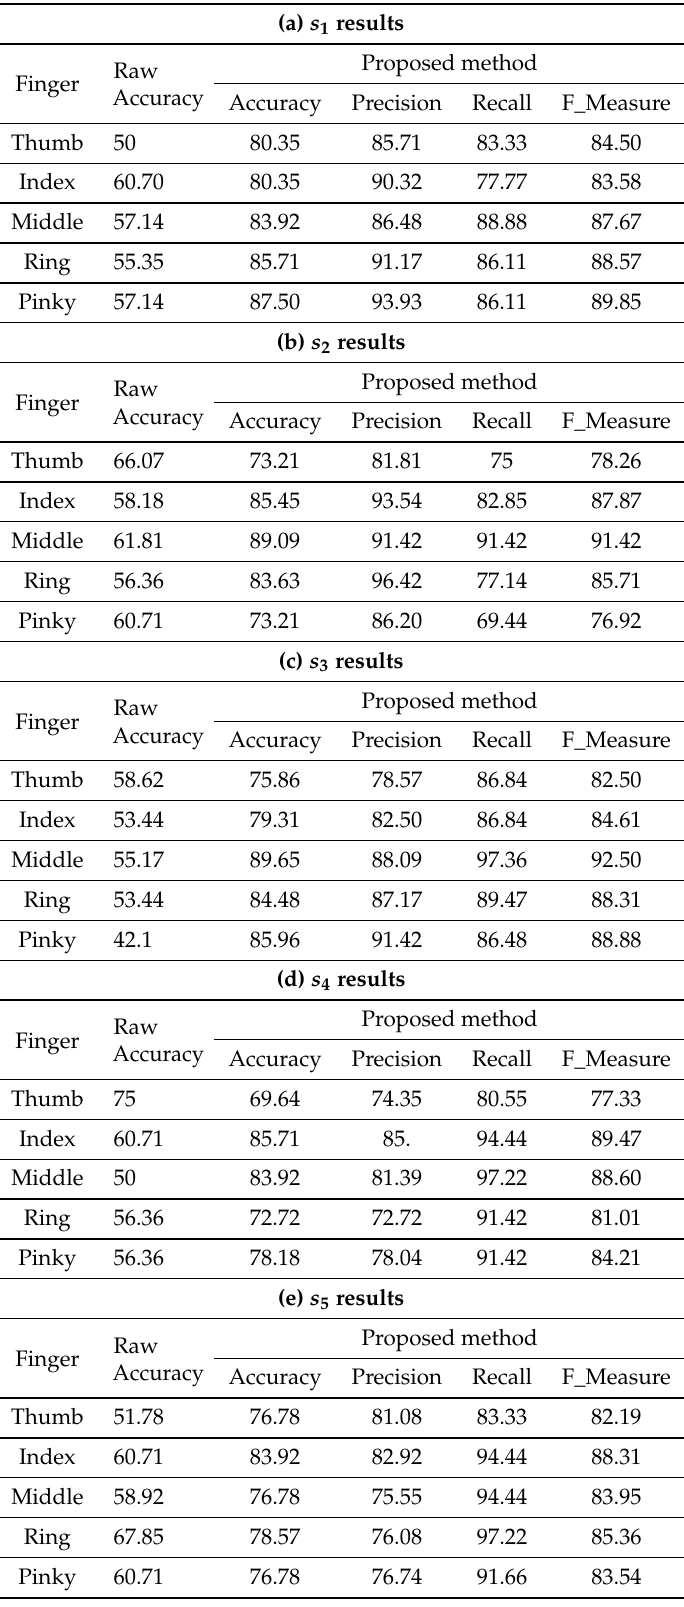
Table 1. Subject’s statistical